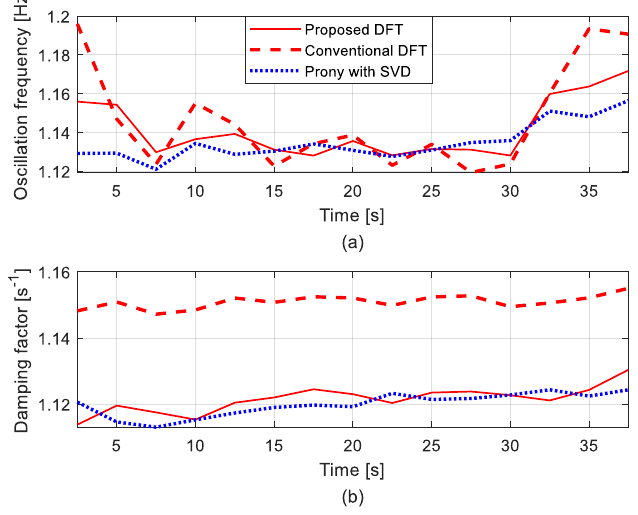
Figure 12. Estimated modal parameters of the New England power system: ( a ) oscillation frequency of the regional mode; ( b ) damping factor of the regional mode.